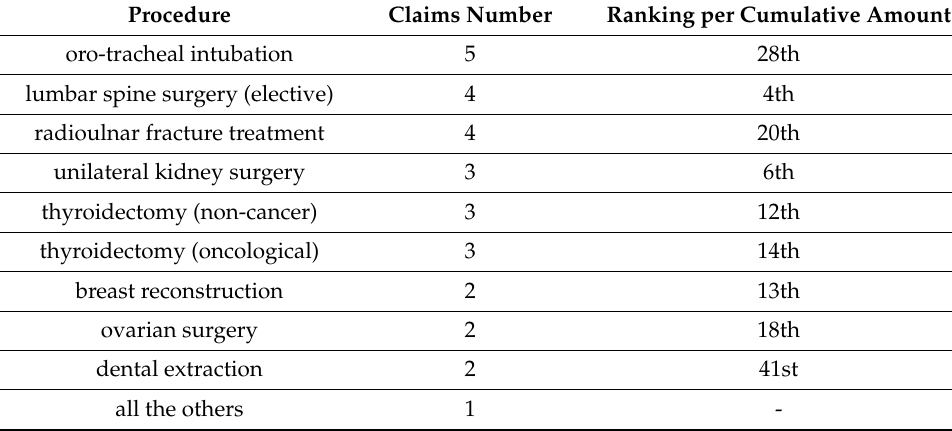
Table 5. Claims number per kind of invasive procedure.